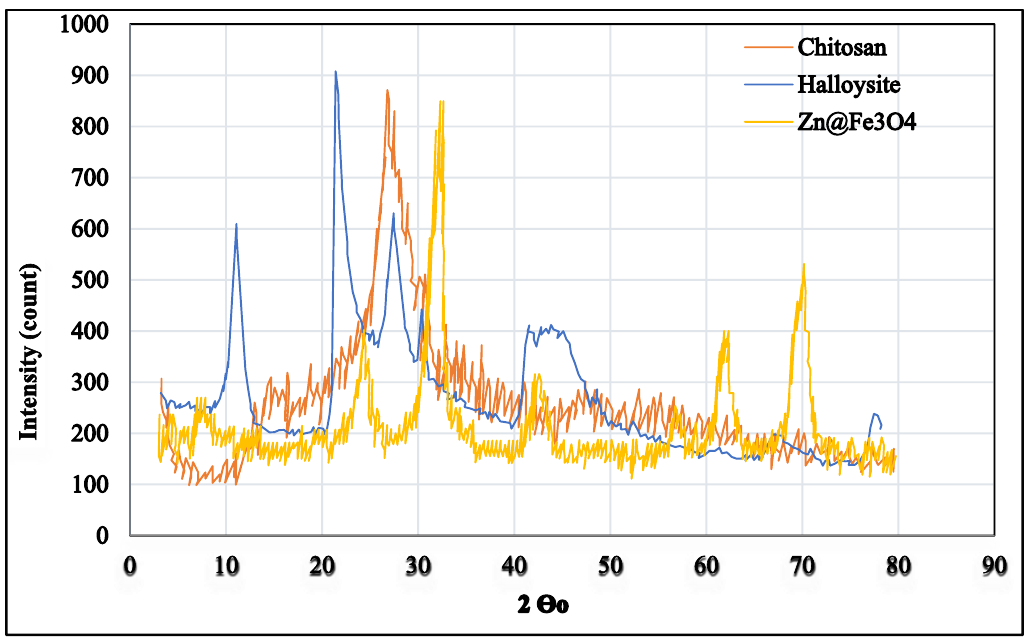
Figure 5. X-ray diffractions (XRD) for chitosan, halloysite, Zn@Fe 3 O 4 , and composite.